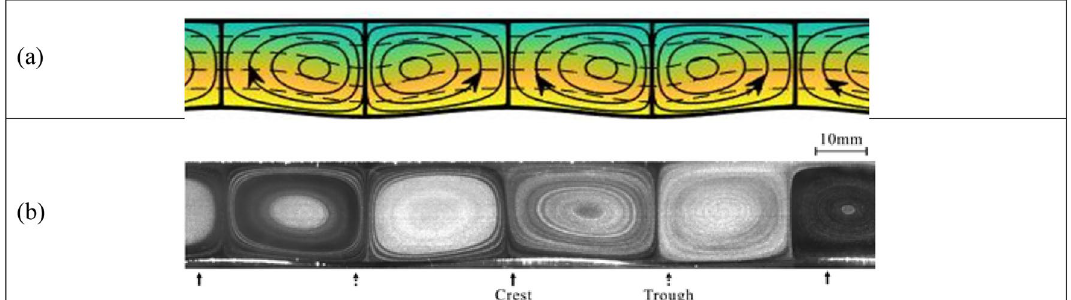
Figure 1. Convection in a slot formed by isothermal plates, with spatial modulations entering the system in the form of periodic grooves added to the lower plate for uniform Rayleigh number Ra uni = 210 , the groove amplitude A = 0.1 and the groove wave number α = 1 . Further details are provided in the “Methodology” section. ( a ) Theory (colors illustrate the temperature field with equally spaced isotherms; blue—the lowest temperature); ( b ) experiment (different levels of grey result from smoke visualization; Supplementary movie A).